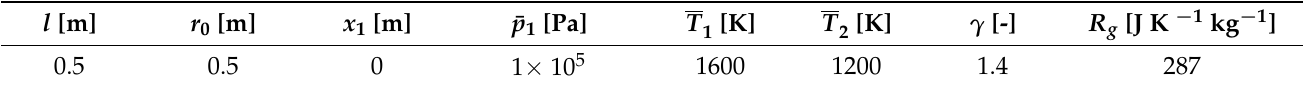
Table 1. Parameters fixed in the analyses.